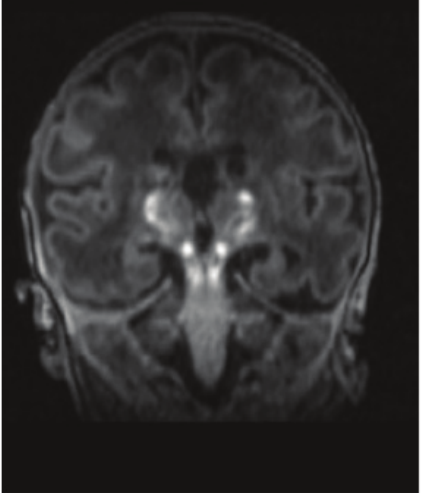
Figure 4: Postnatal cephalic MRI. T1 hyperintense pyramidal tract